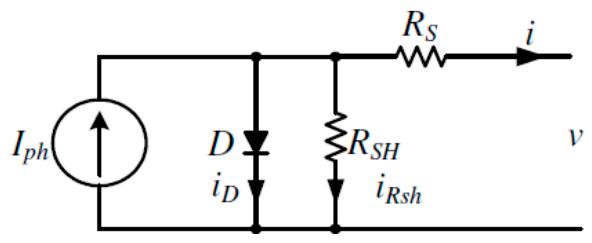
Figure 1. Electrical Equivalent of PV Cell on one-diode model [21].